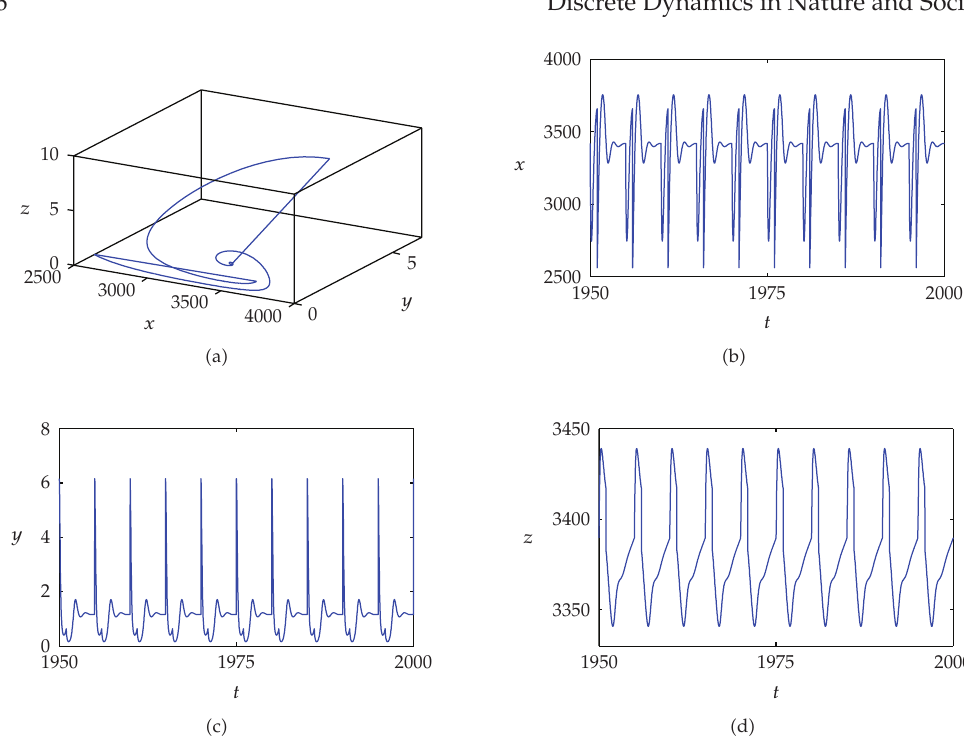
Figure 2: a (cid:7) 4 . 0, b (cid:7) 0 . 001, c (cid:7) 0 . 5, c 1 (cid:7) 0 . 01, d 1 (cid:7) 0 . 3, d 2 (cid:7) 0 . 02, e 1 (cid:7) 0 . 01, e 2 (cid:7) 0 . 02, p 1 (cid:7) 0 . 3, p 2 (cid:7) 0 . 1, p 3 (cid:7) 0 . 01, τ (cid:7) 0 . 2, and T (cid:7) 5. (cid:2) a (cid:3) The trajectory of system (cid:2) 1.2 (cid:3) when q (cid:7) 5. (cid:2) b (cid:3) – (cid:2) d (cid:3) Time series.